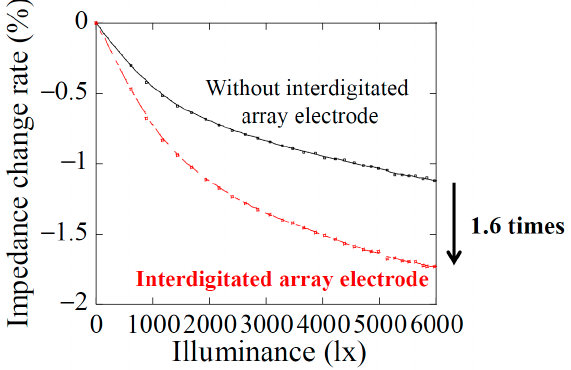
Figure 6. Optical responsivity of the sensor with and without interdigitated array electrodes, respectively.